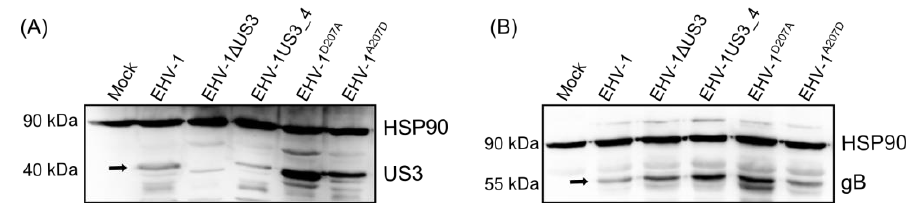
Figure 1 . Analysing US3 expression by western blot. Cells were either infected with parental, mutant, recombinant, or revertant viruses. Cell lysates were prepared with radioimmunoprecipitation assay (RIPA) buffer. The pUS3 ( A ) and gB ( B ) proteins were separated by 12% sodium dodecyl sulfate-polyacrylamide gel electrophoresis (SDS-PAGE). The expression of pUS3 and gB (black arrows) were detected with anti-US3 and anti-gB antibodies, respectively. Heat shock protein 90 α / β (HSP90 α / β , 1:1000 dilution) was used as a loading control